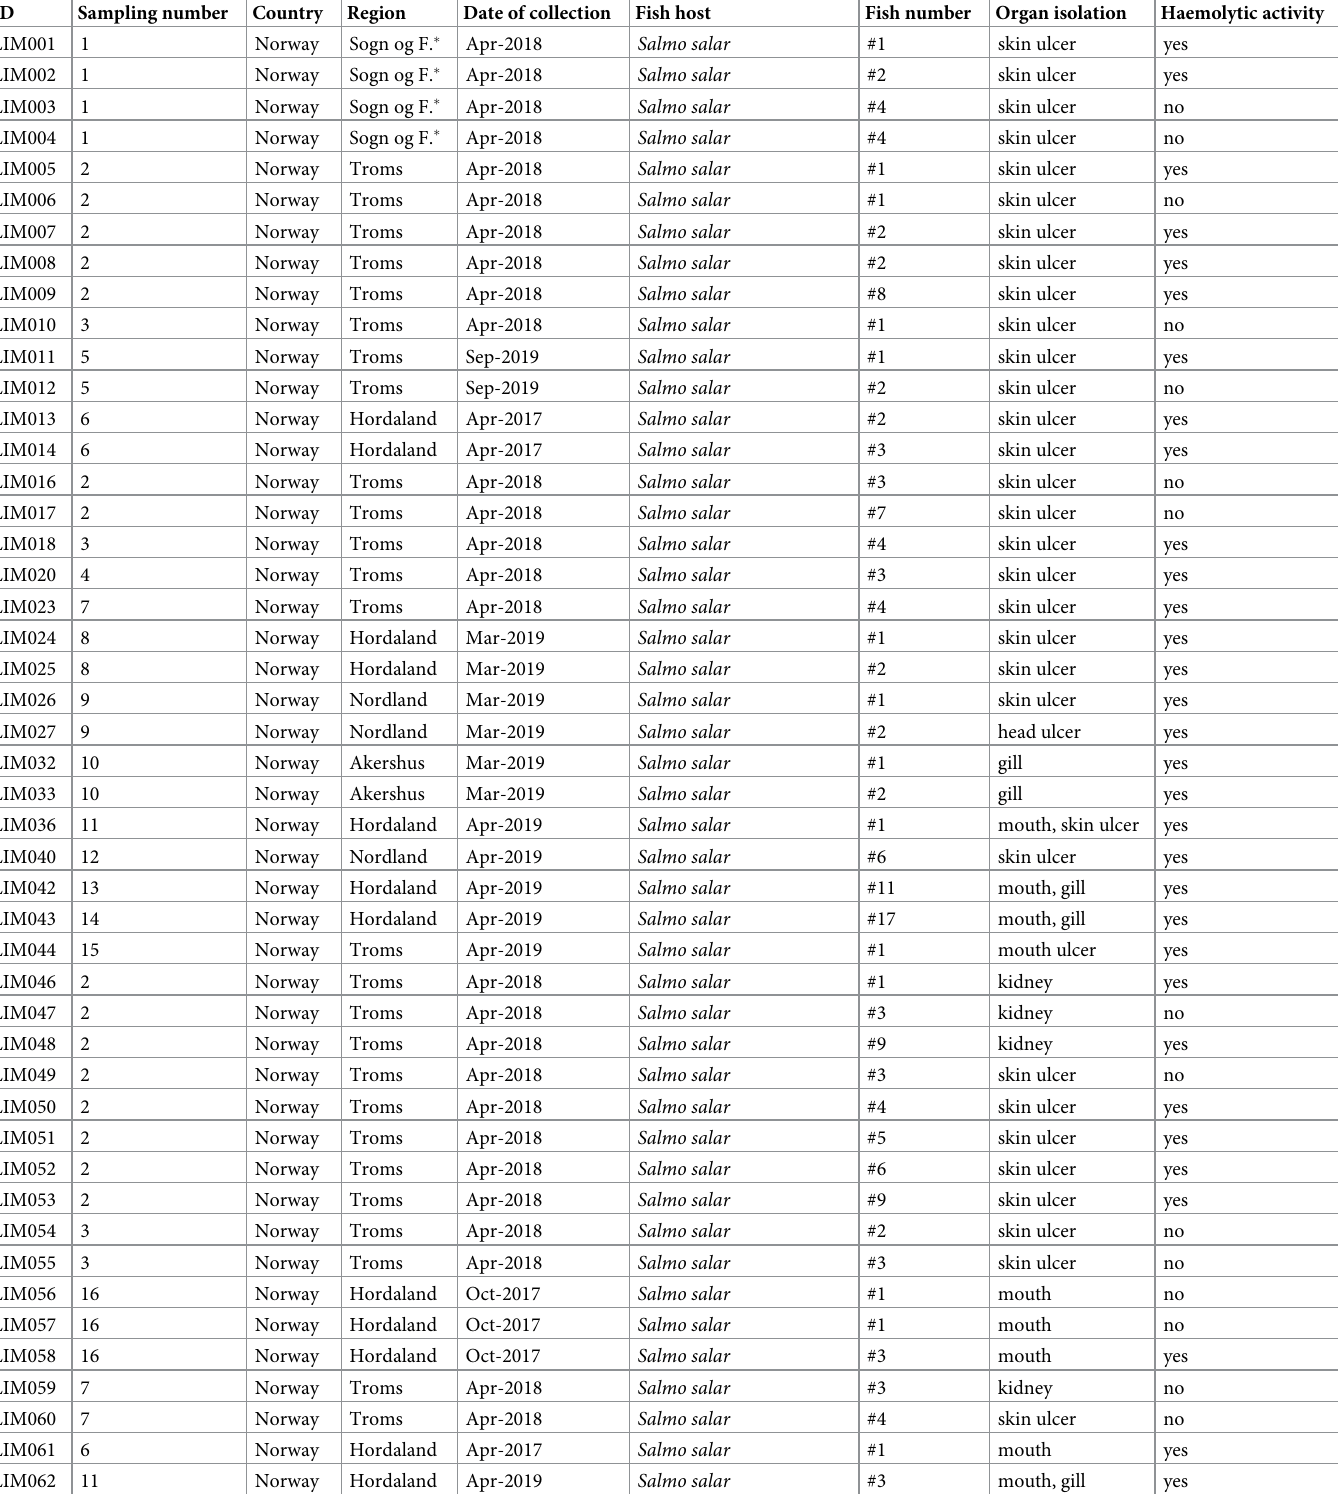
Table 1. Data associated with the 66 Tenacibaculum strains isolated during this